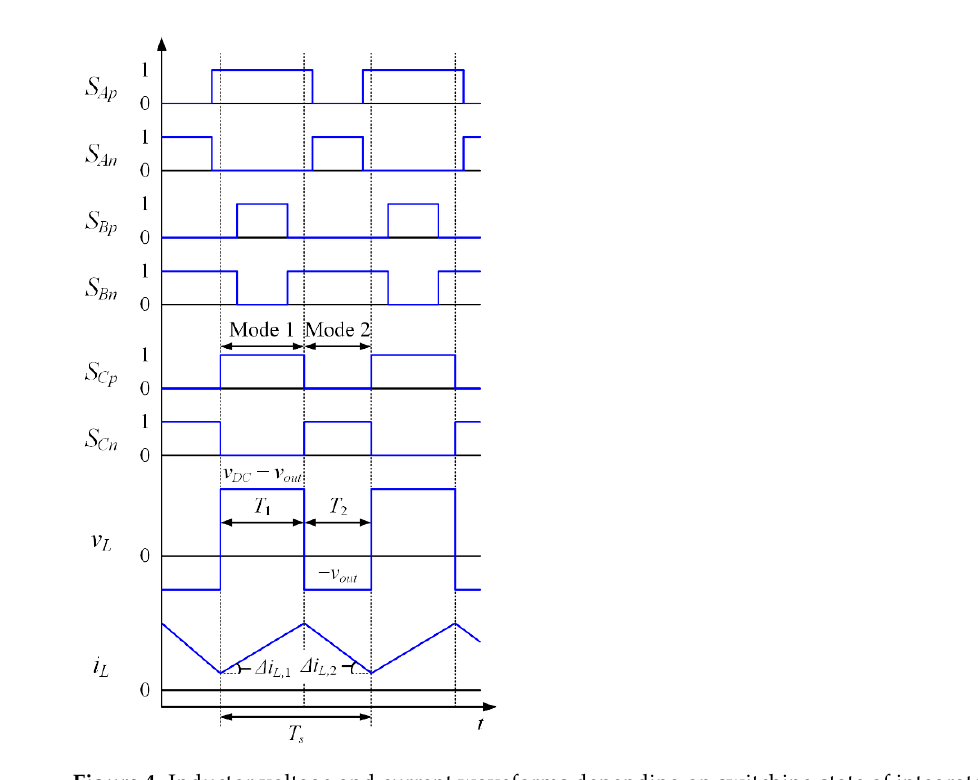
Figure 4. Inductor voltage and current waveforms depending on switching state of integrated OBC.